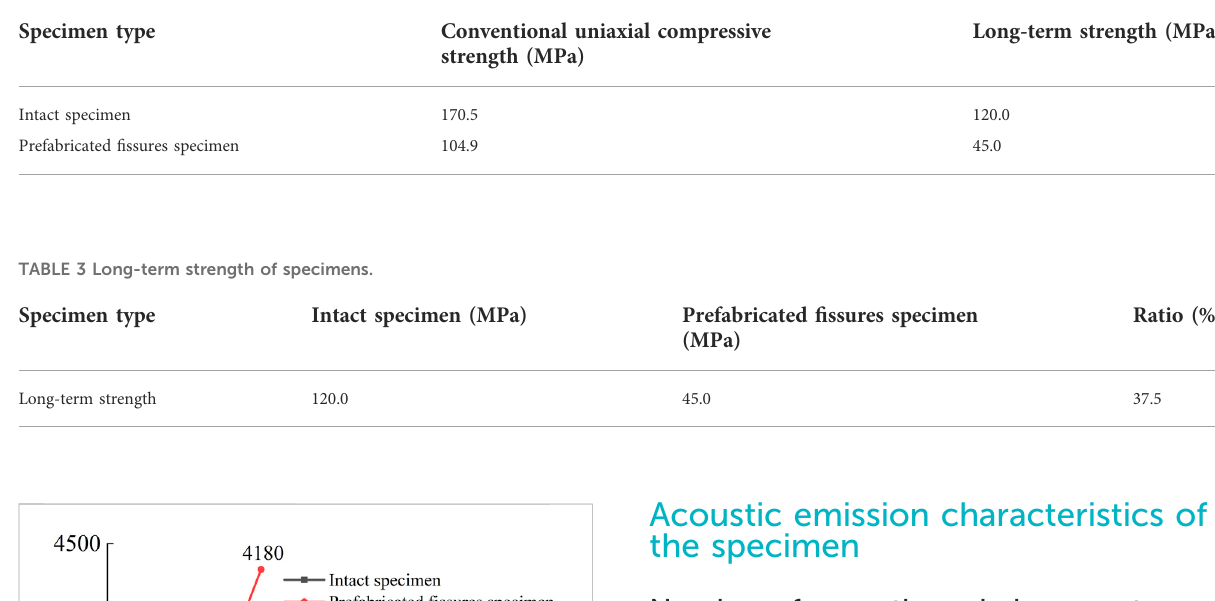
TABLE 2 Comparison of conventional uniaxial compressive strength and long-term strength of specimens.